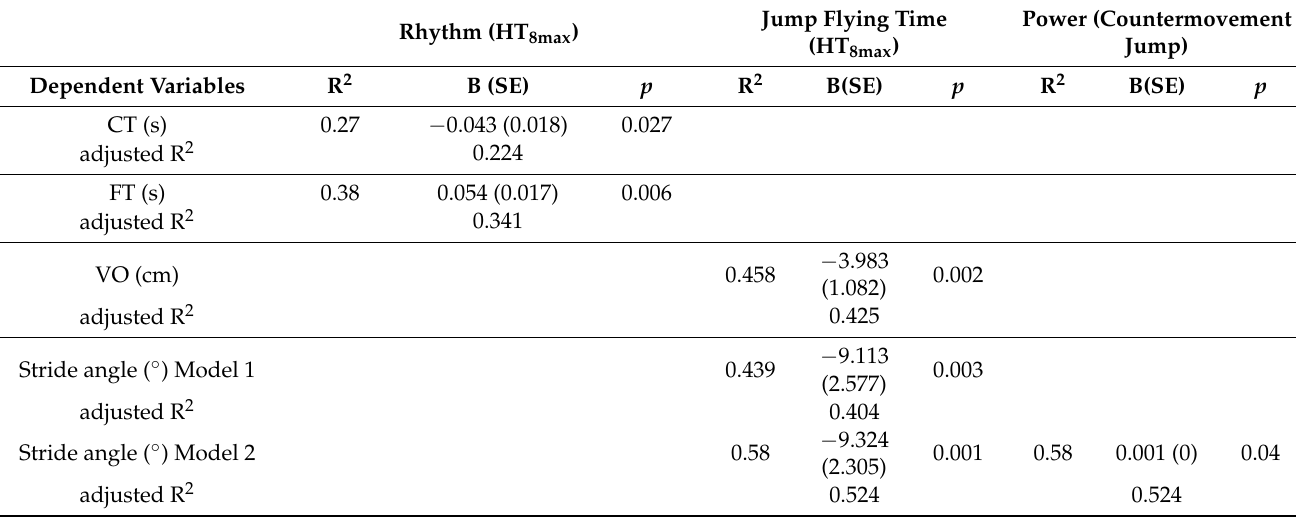
R 2 = coefficient of determination R square; B = coefficient; SE = standard error; CT = contact time; FT = flying time; VO = vertical oscillation. Model 1: adjusted for jump flying time (HT 8max ). Model 2: adjusted for jump flying time (HT 8max ) and power (countermovement